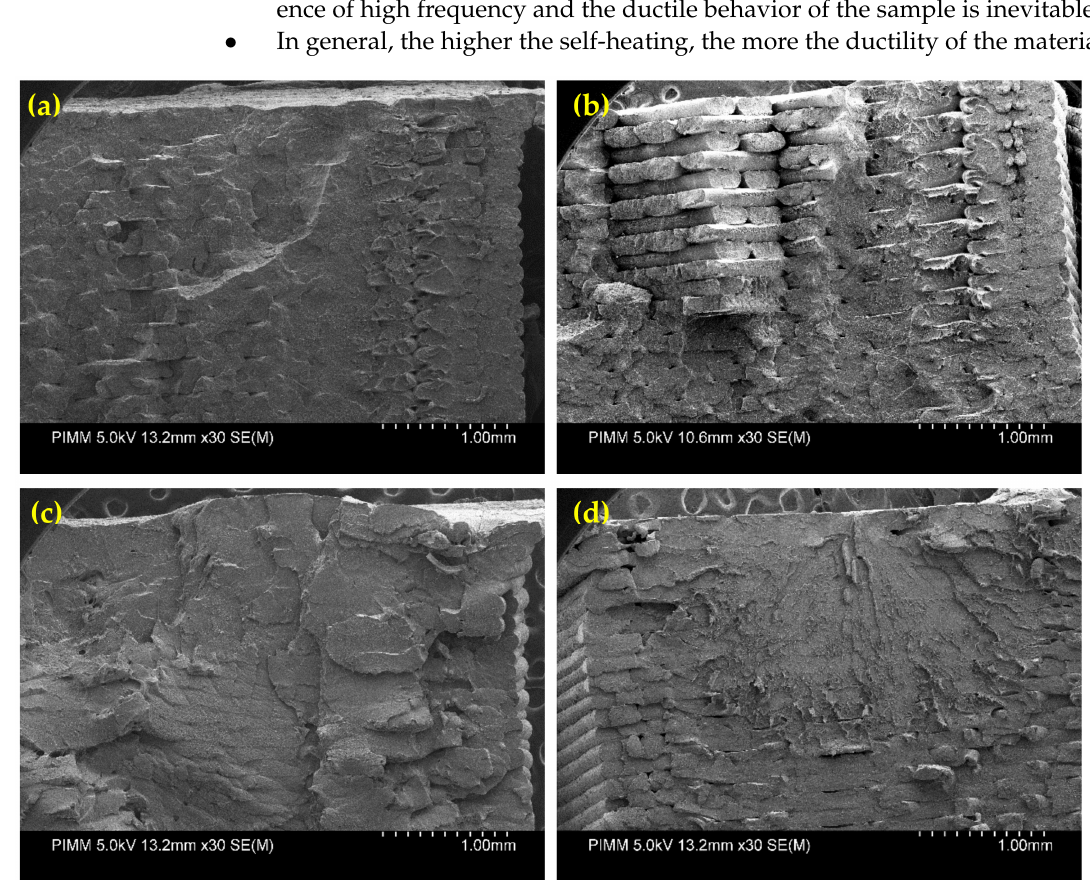
Figure 13. SEM micrograph for fracture surface during fatigue test of the specimen in condition I-1: ( a ) σ = 24 MPa–f = 10 Hz and ( b ) σ = 52 MPa–f = 10 Hz; and in condition III-1: ( c ) σ = 24 MPa–f = 80 Hz and ( d ) σ = 52 MPa–f = 80